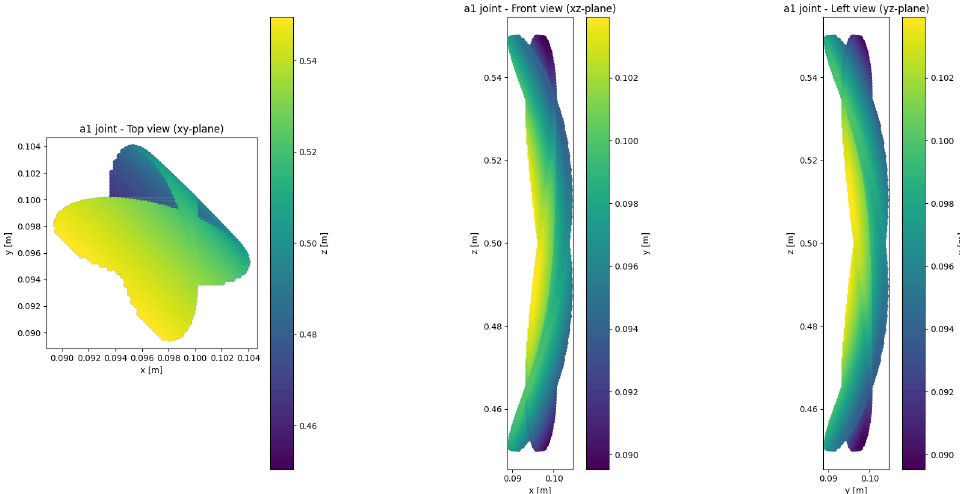
Figure 7. Workspace analysis for optimum configurations projected in 2D space for z = 0.5